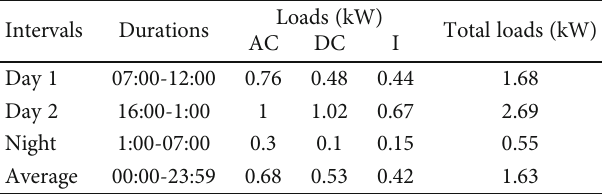
Table 7: Load during di ff erent time intervals [158].